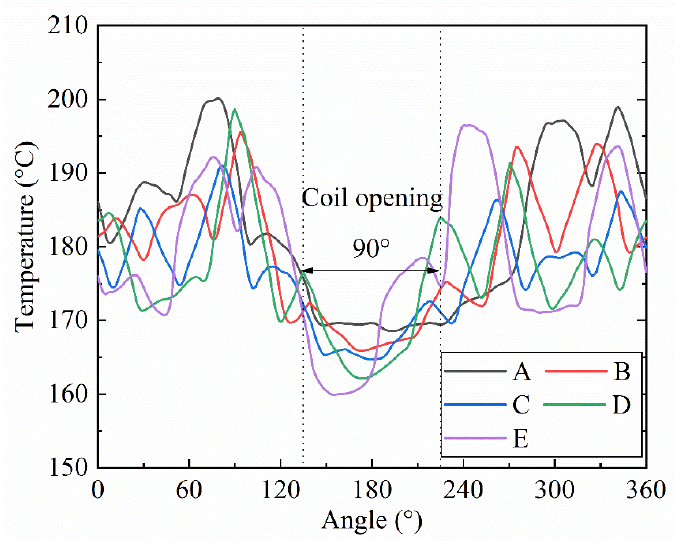
Figure 12. Temperature distribution of the gear tooth surface during LC heating.